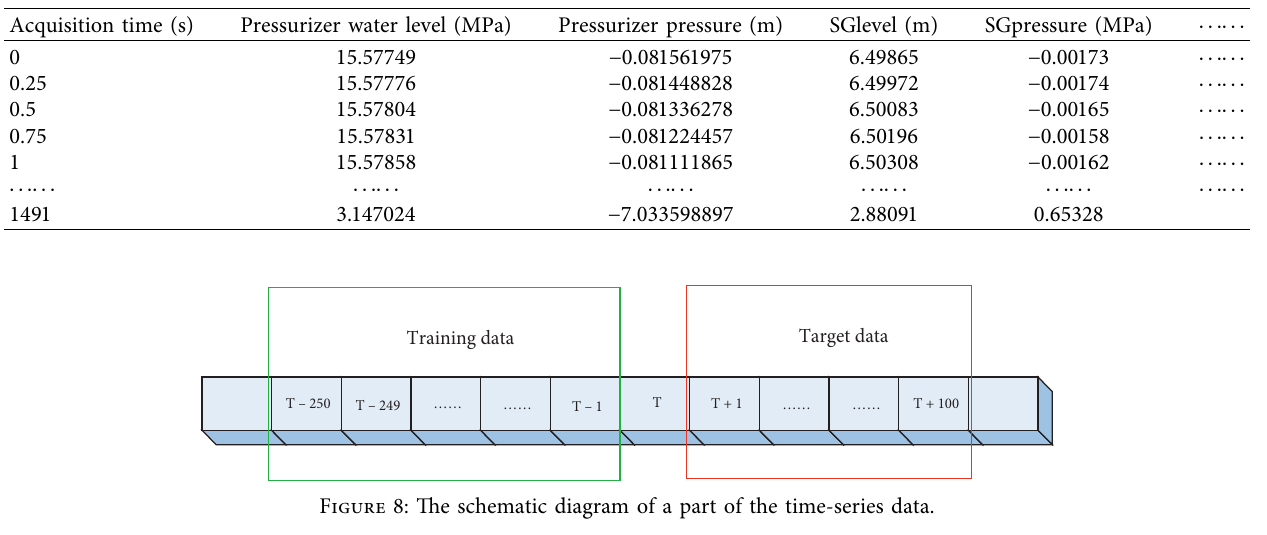
Figure 8: The schematic diagram of a part of the time-series data.